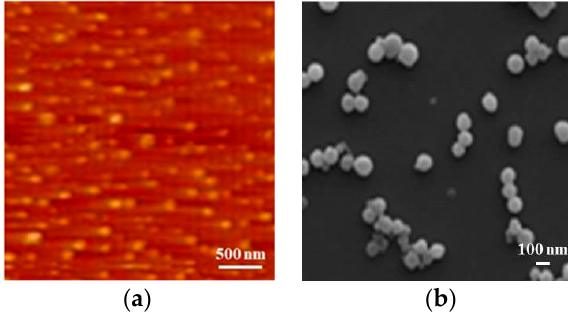
Figure 3. ( a ) AFM and ( b ) SEM images of the freeze-dried OPO/zein-3/10 nanocapsules.